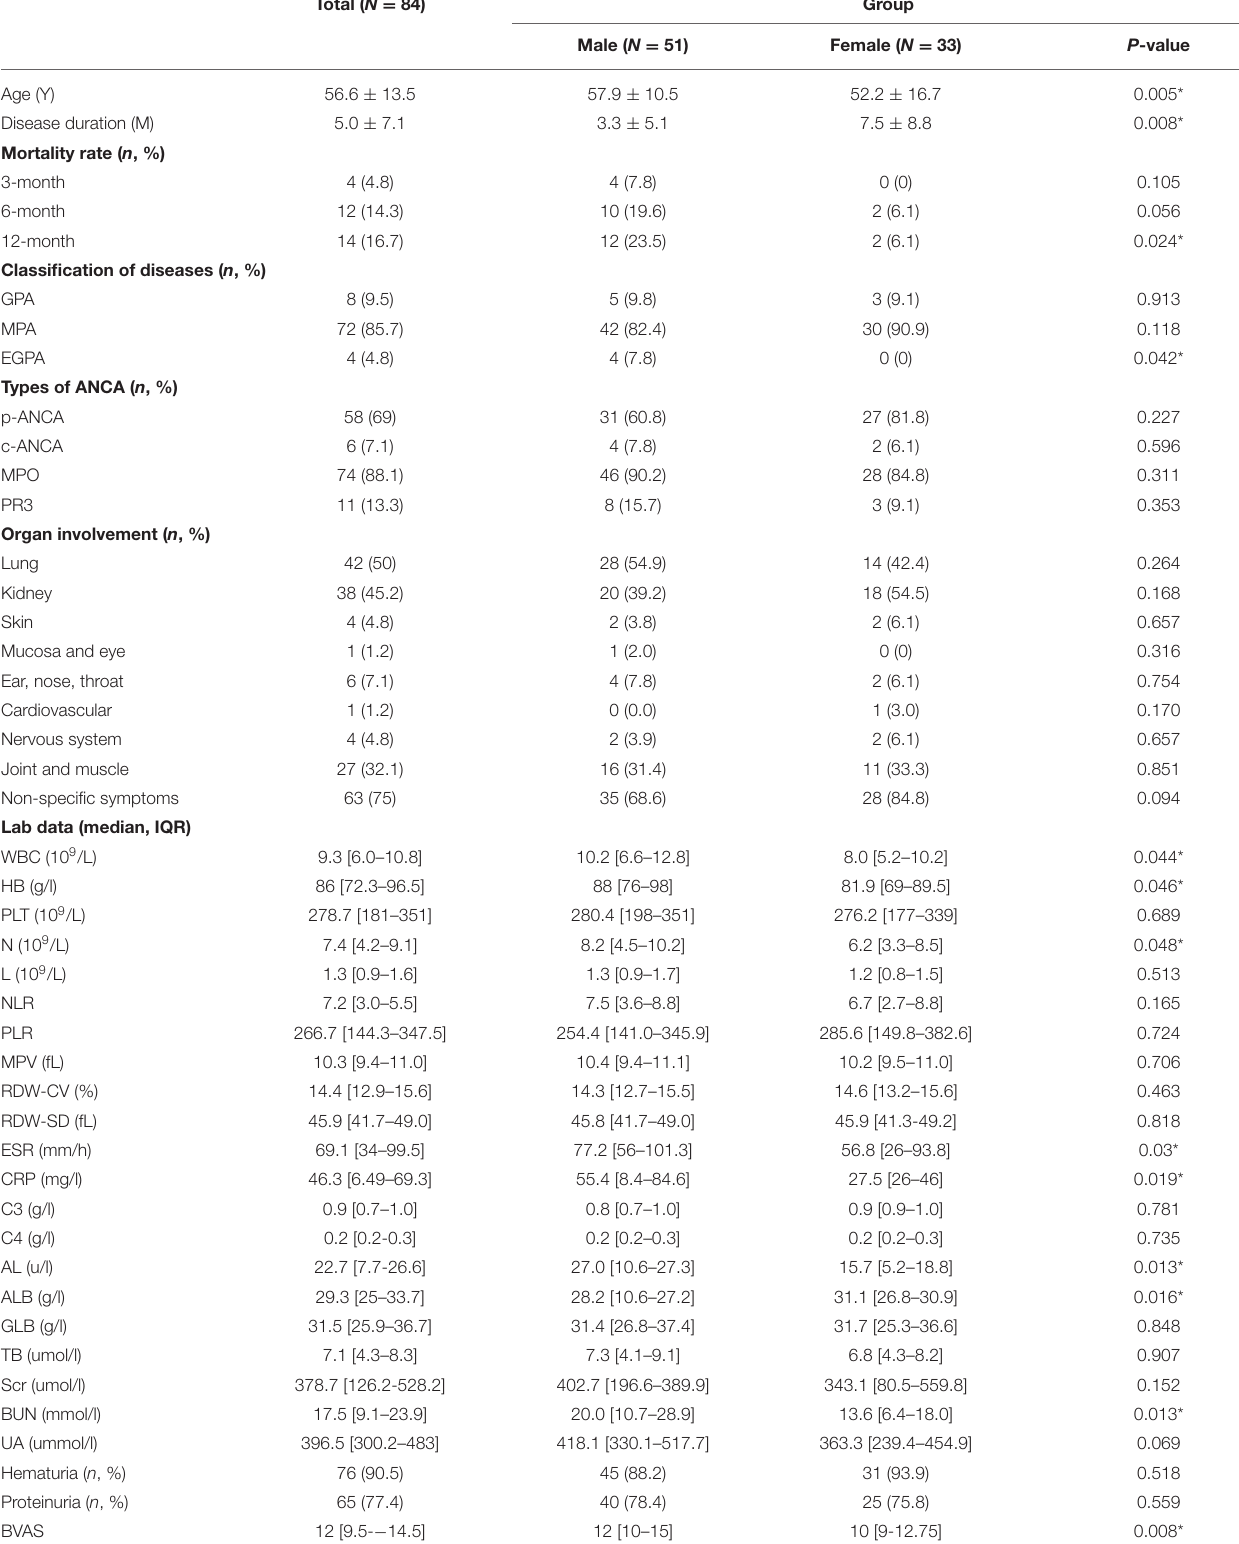
TABLE 1 | Basic characteristics of patients with AAV and comparison between different